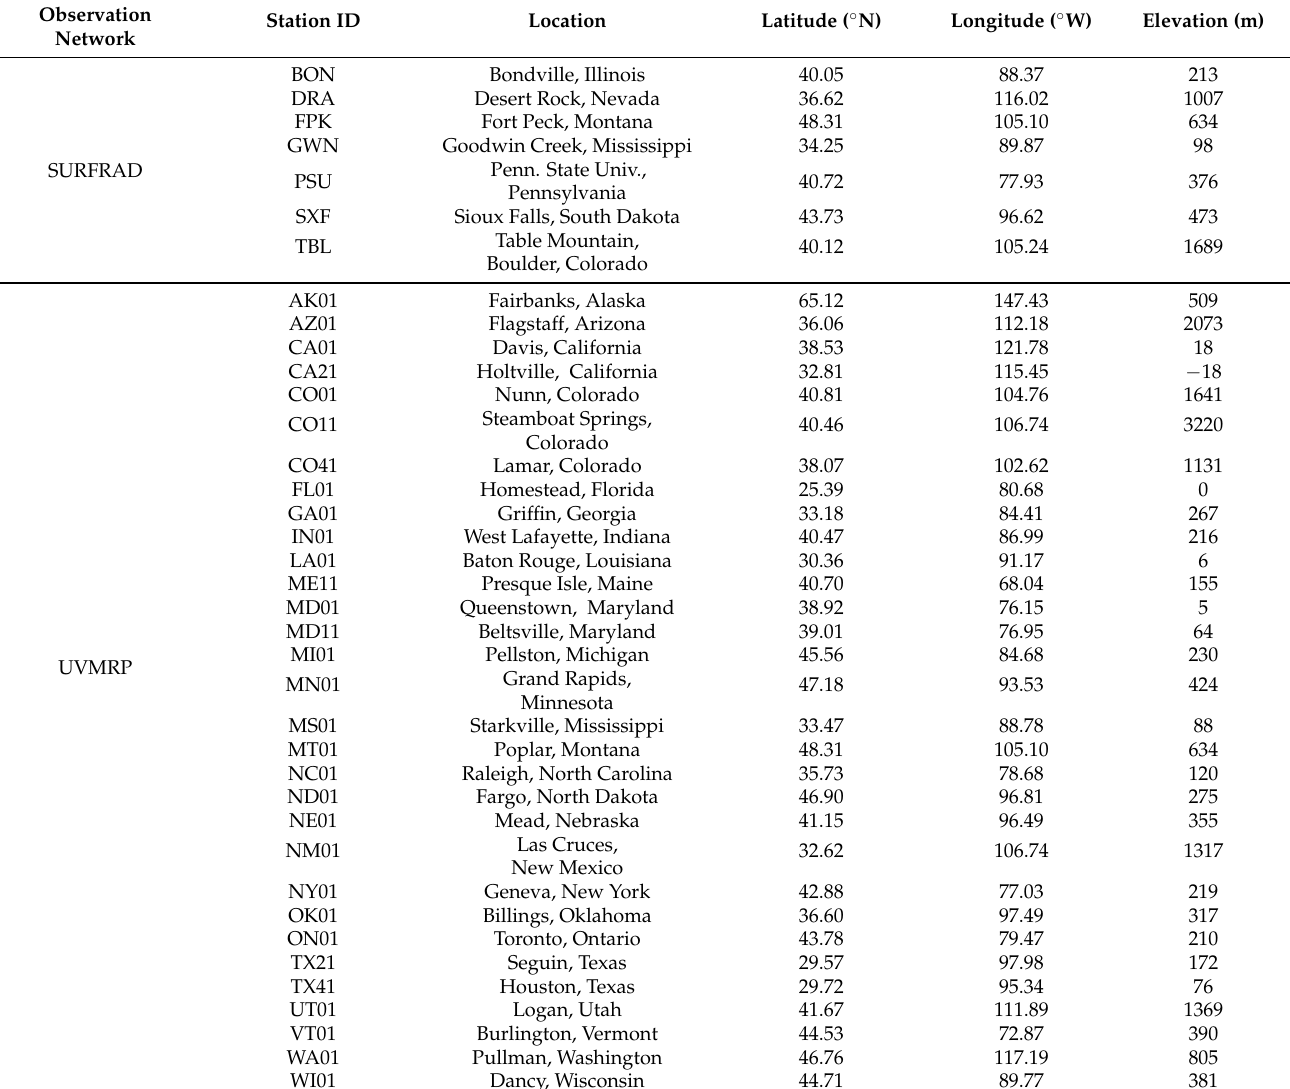
Table 1. The geographic information of SURFRAD and UVMRP sites used in this